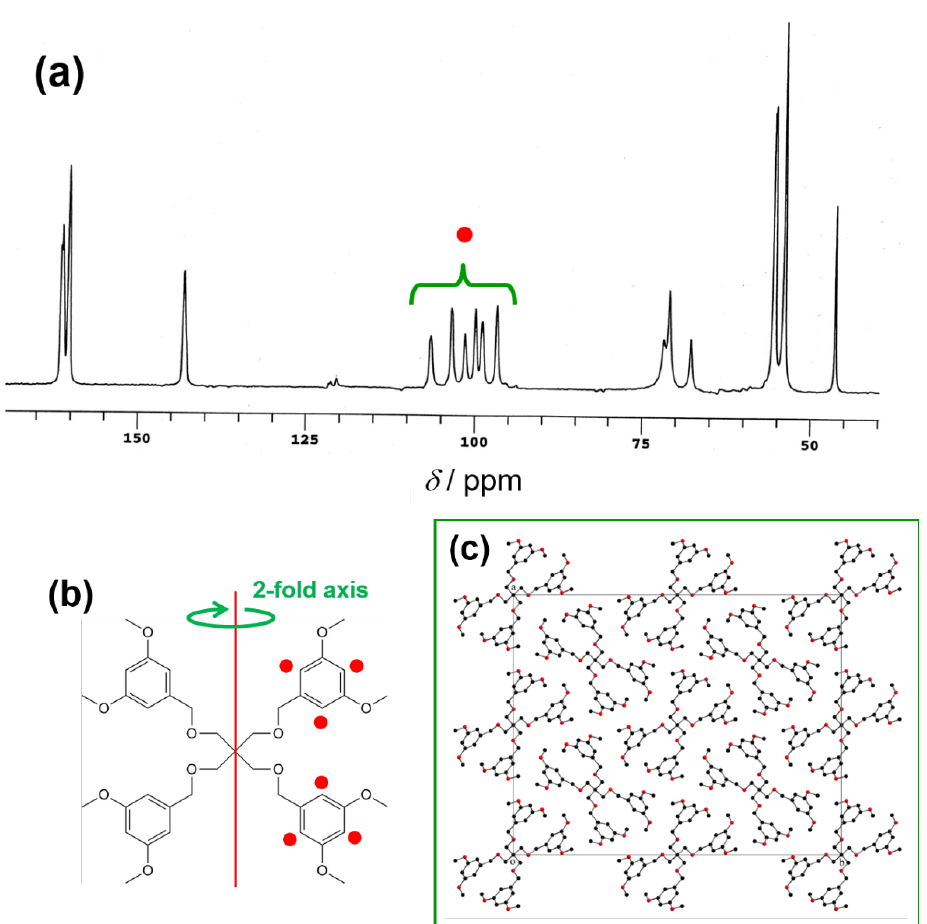
Figure 4. ( a ) Experimental high-resolution solid-state 13 C NMR data recorded for TDMM. The region of the spectrum corresponding to the aromatic CH environments (between 95 ppm and 101 ppm, as indicated by the red circle) contains six distinct peaks, which is half the number (12) of aromatic CH environments in a single molecule, suggesting that the TDMM molecule is located on a 2-fold rotation axis in the crystal structure. ( b ) Illustration of the relationship between molecular symmetry and crystallographic symmetry in the crystal structure of TDMM, with the central carbon atom of the molecule located on a crystallographic 2-fold rotation axis; the six aromatic CH environments in the asymmetric unit are indicated by red circles. ( c ) The crystal structure of TDMM determined from powder XRD data (hydrogen atoms are omitted for